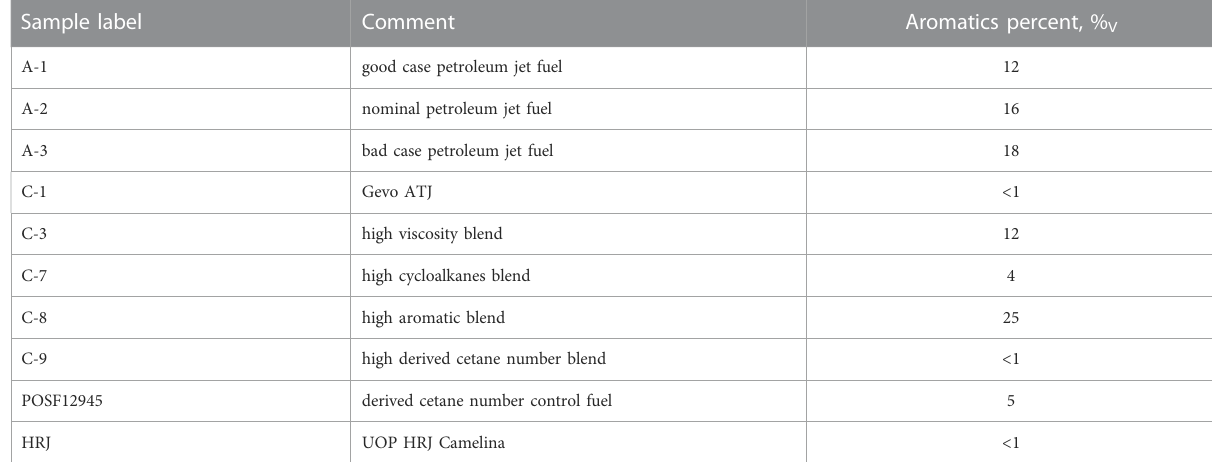
TABLE 2 List of complex mixtures (fuels) as stock for the mixtures investigated. The supplier of each of these fuels and data was the air force research laboratory, Fuels Branch (Edwards, 2017; Altjetfuels, 2021). Sample label